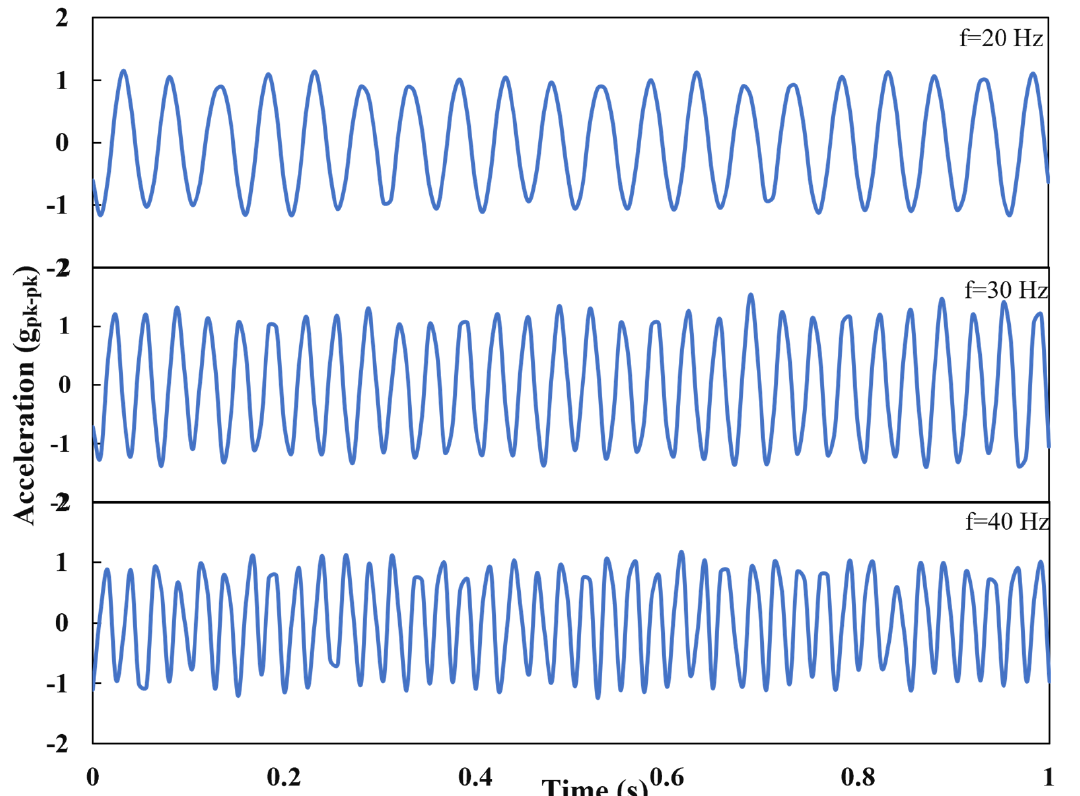
Figure 3. Time response of acceleration at three representative frequencies.